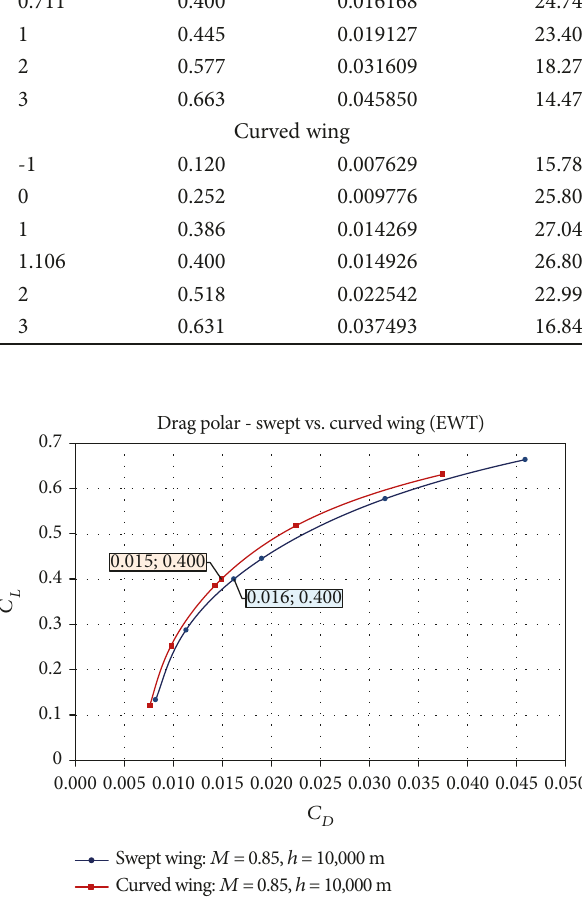
Figure 11: Supersonic region (curved wing: isoview rear).